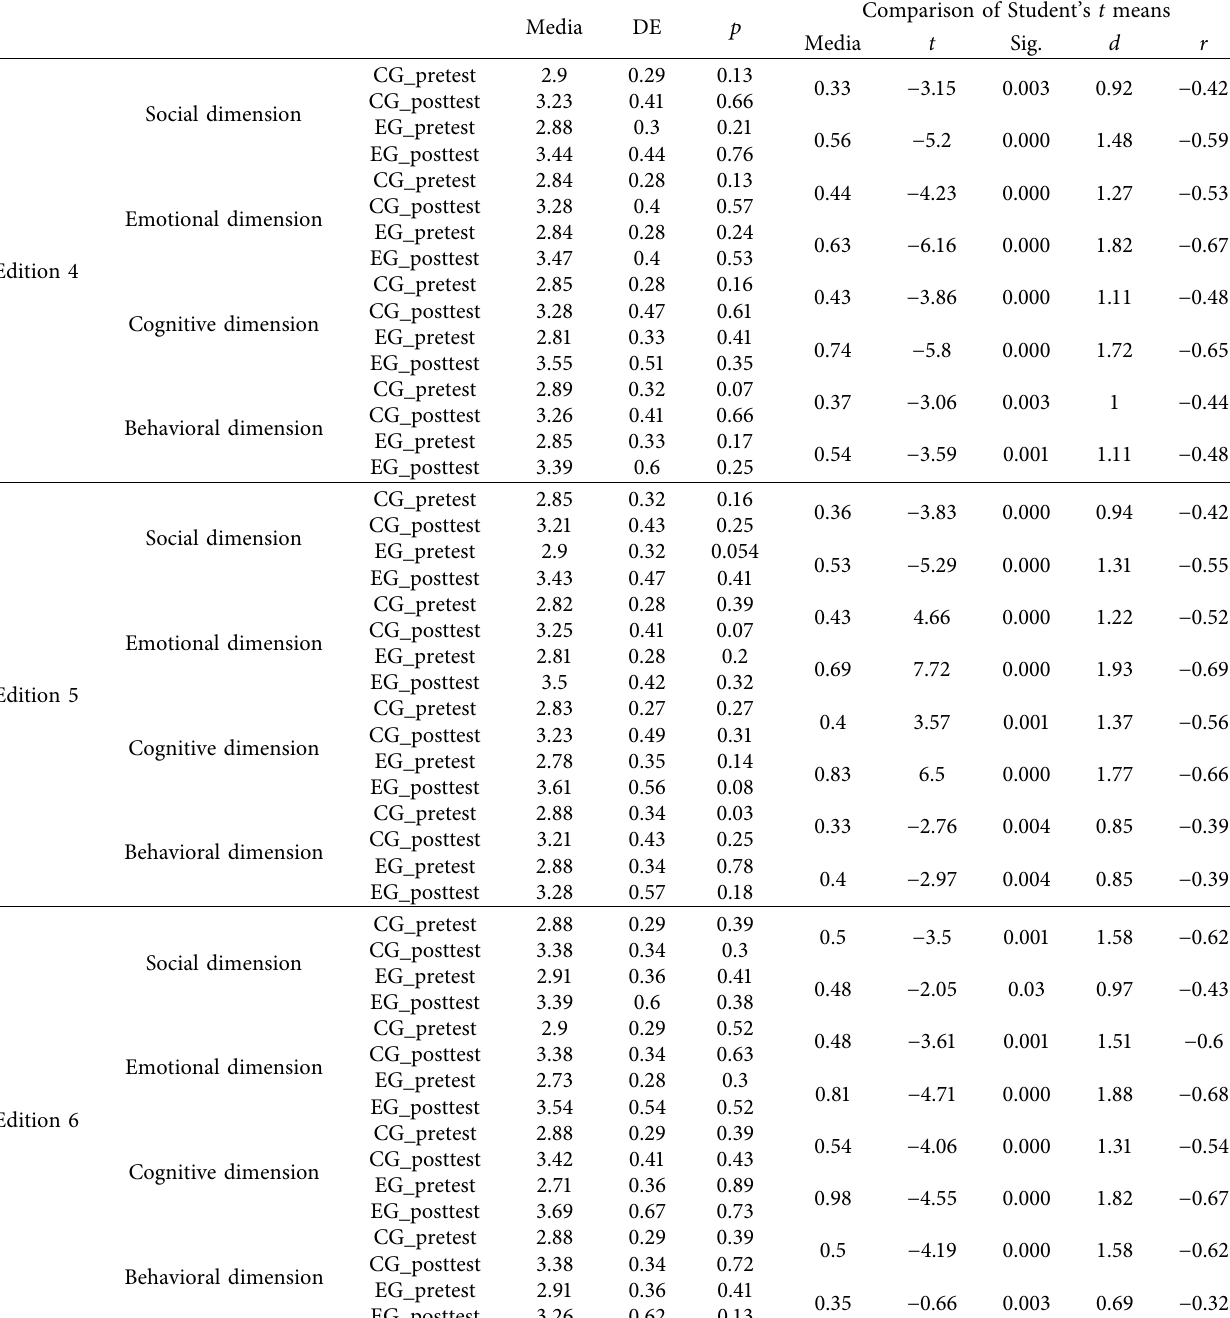
Table 3: Pre- and posttest statistics (first last